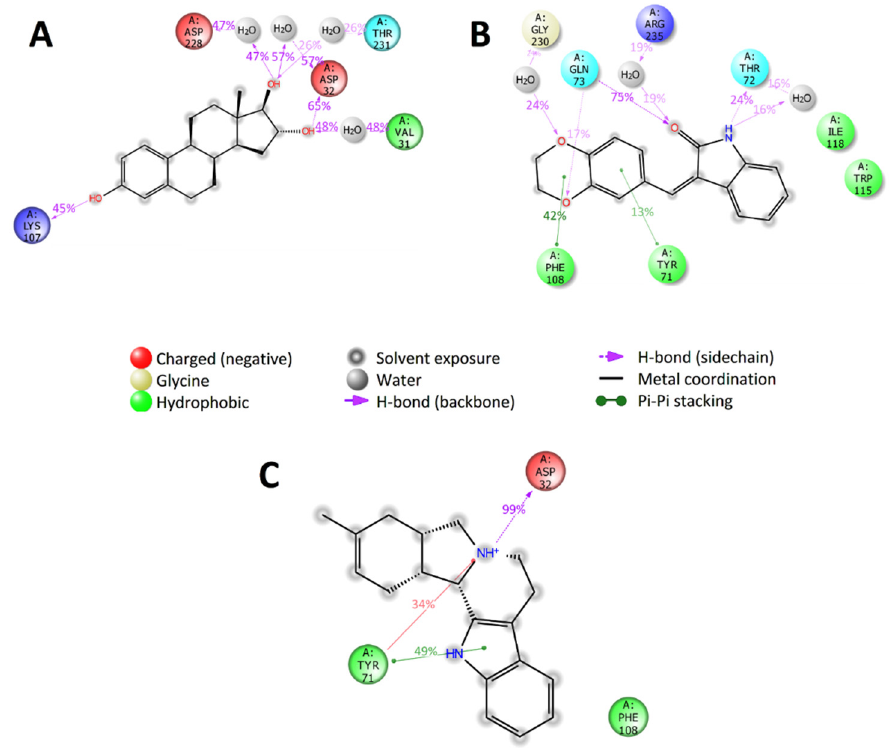
Figure 7. 2D summary diagram of molecular dynamics calculated contacts between BACE1 and small-molecule ligands ( A ) ZINC3977996, ( B ) ZINC1034491 and ( C ) ZINC4027357. Interactions that occur more than 10% of the simulation time are shown.